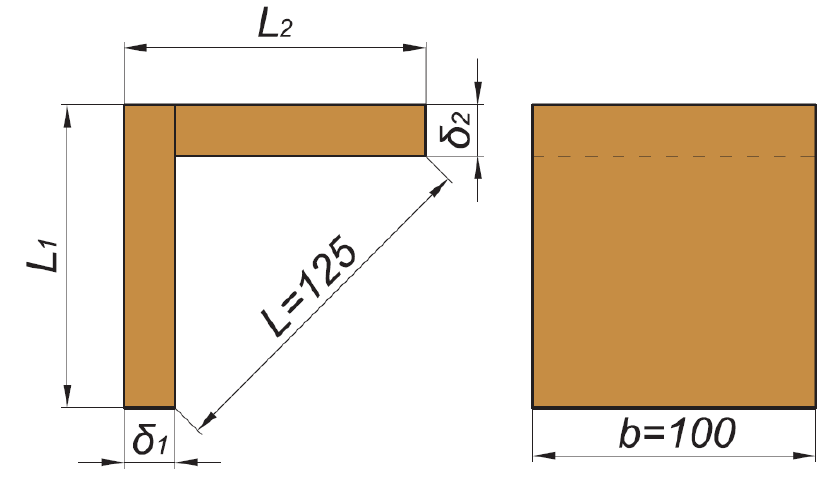
Figure 5. Type and dimensions of the tested samples. Reprinted with permission from Ref. [11]. 2021 BISMAR.